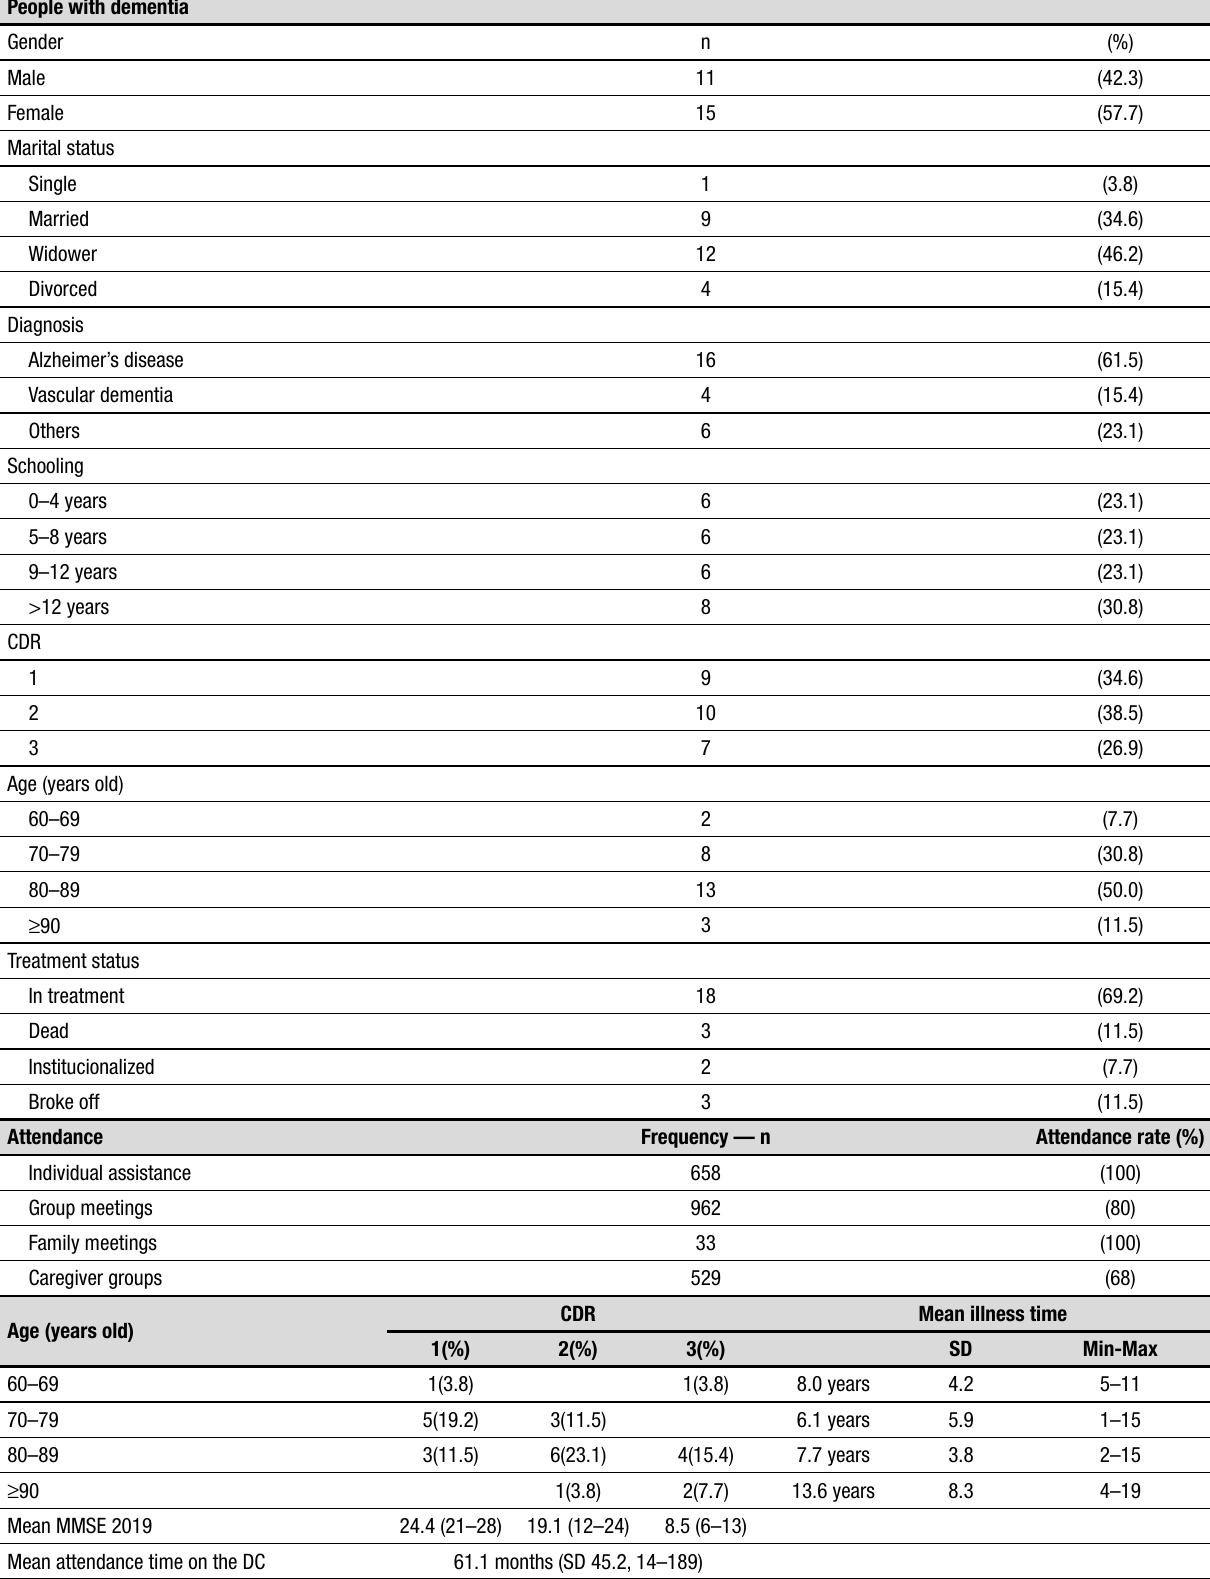
Table 1. Characteristics of people with dementia and their family caregivers. People with